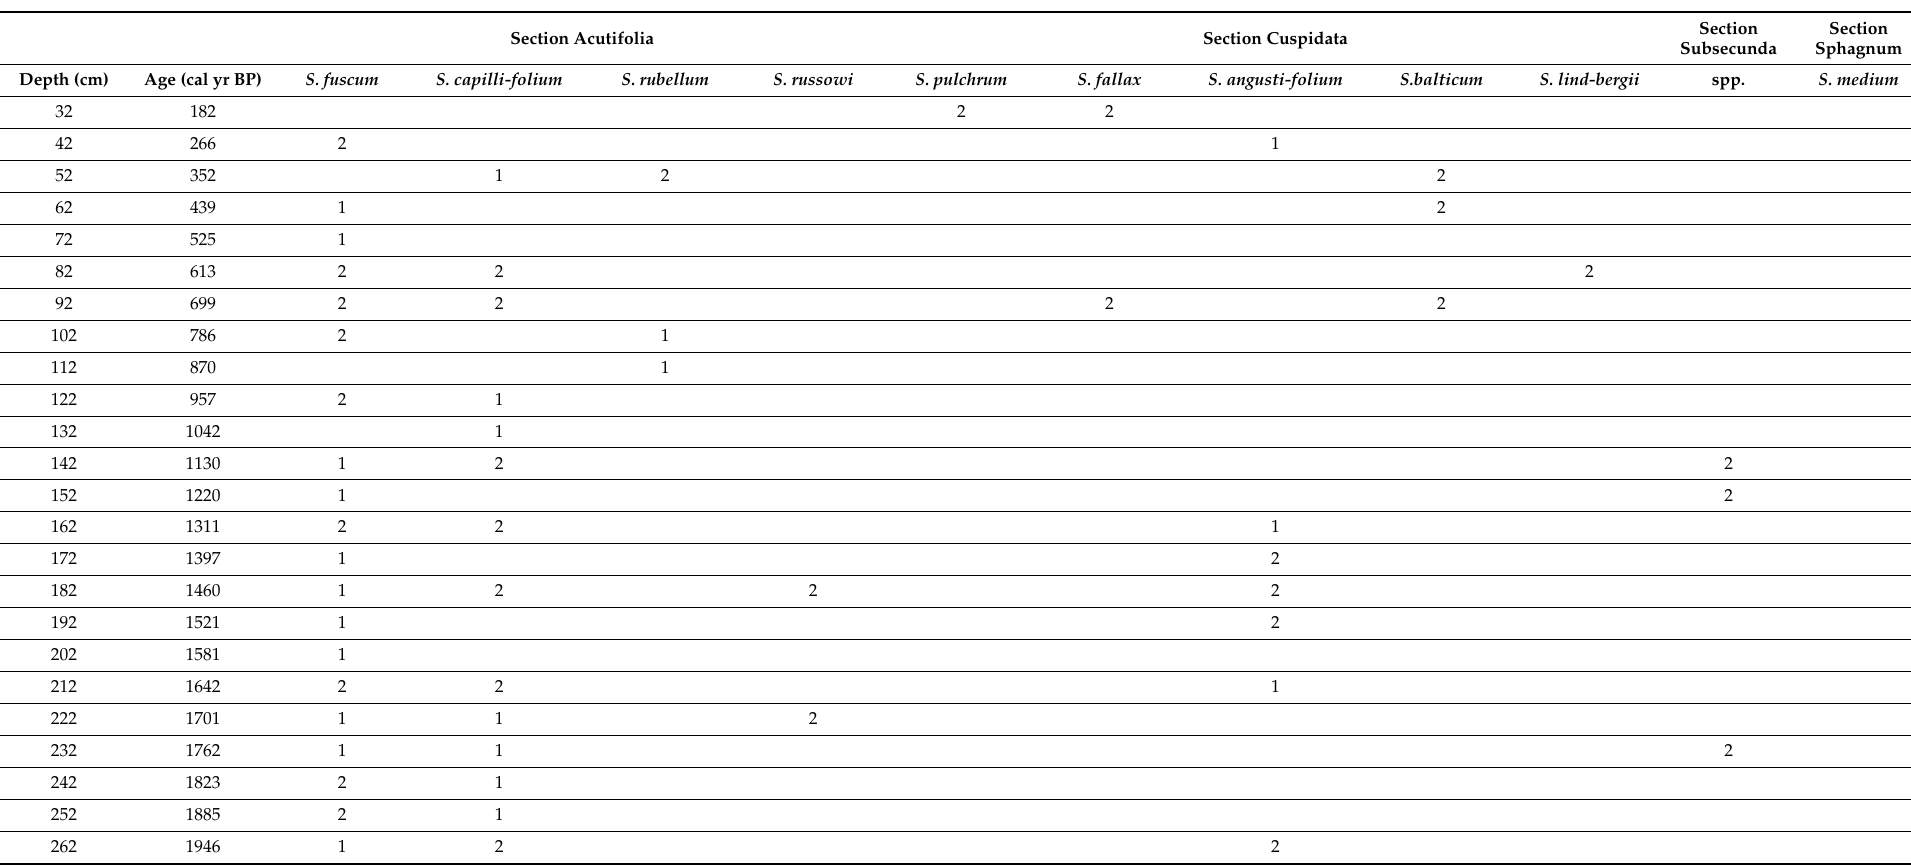
Table 2. Sphagnum species identification at each sampled depth. A ‘1’ indicates that a species was the most common at that interval. A ‘2’ indicates that the species was present, but not the most